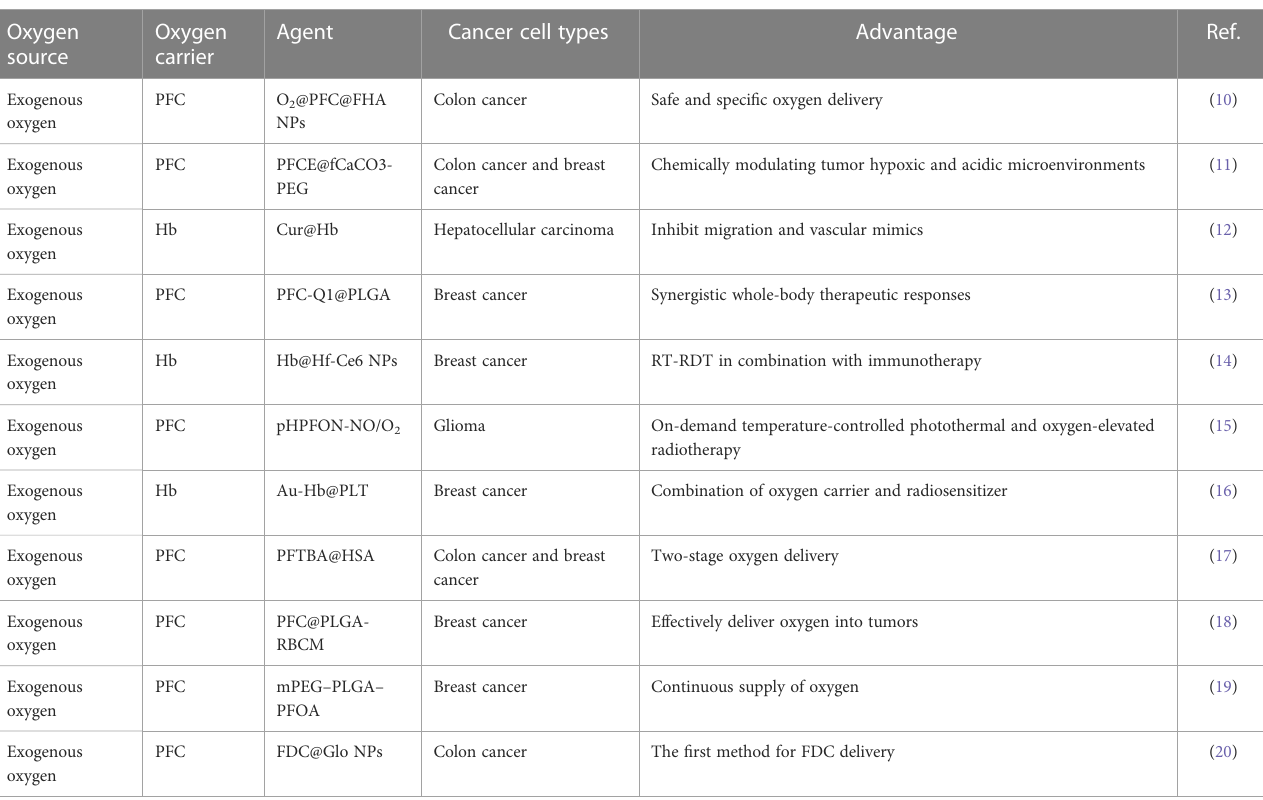
TABLE 1 Physical strategies-based oxygen